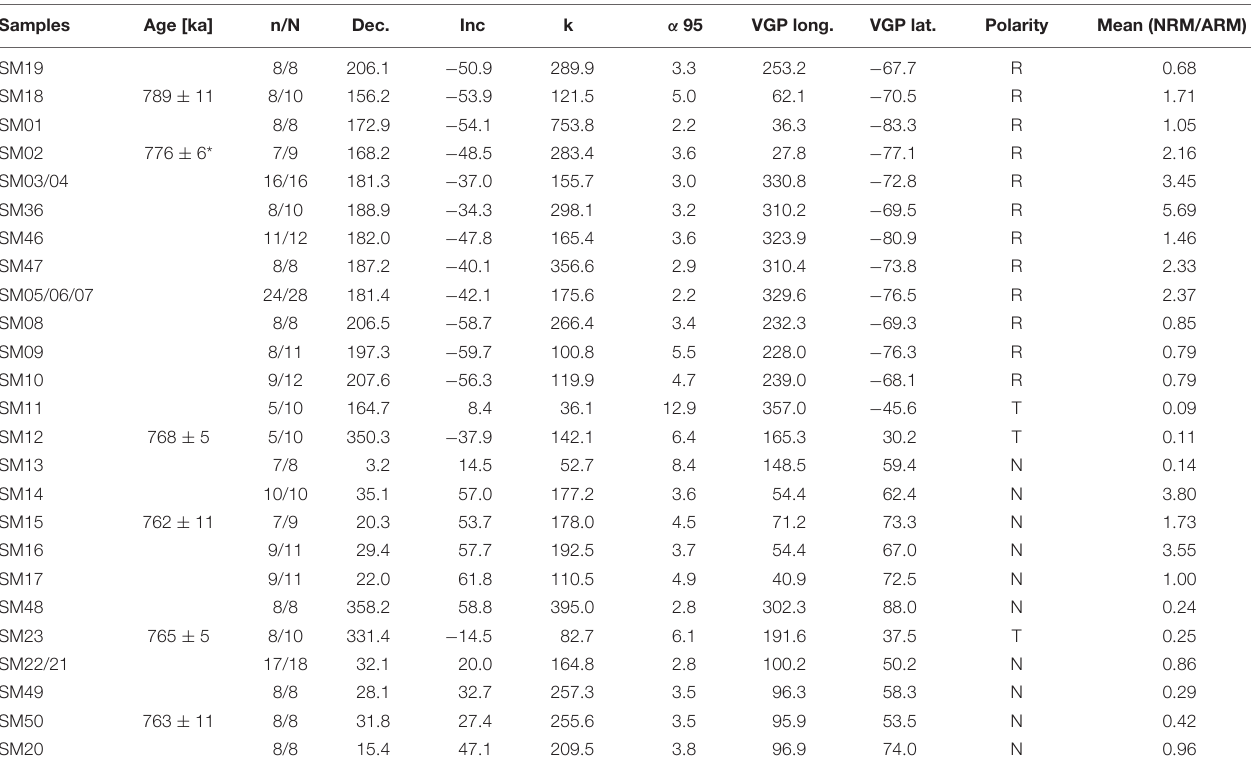
TABLE 1 | Paleomagnetic